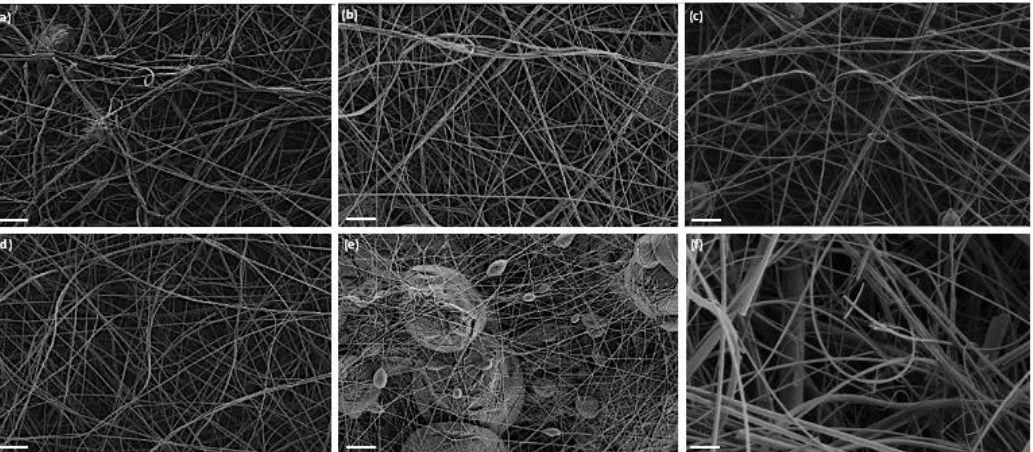
Figure 2. SEM micrographs at different magnification (from 5000× to 7000×) of the membranes obtained with different PAN/PCL ratio. ( a ) PAN 50%; ( b ) PAN 70%; ( c ) PAN 90%; ( d ) stock PAN 100%, ( e ) stock PCL 100%, ( f ) reference glass microfiber. Scale bars = 4 μm for ( a – f ).